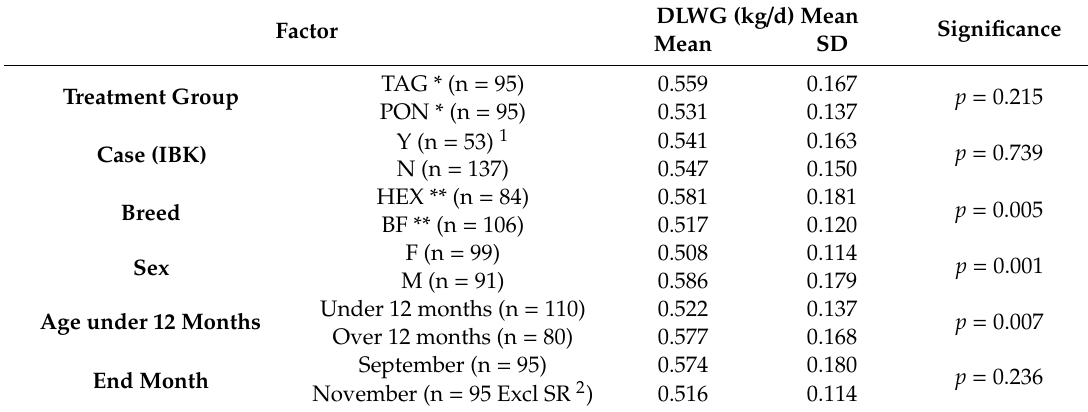
Table 3. Daily live weight gain (DLWG) di ff erences between each factor and significance values.